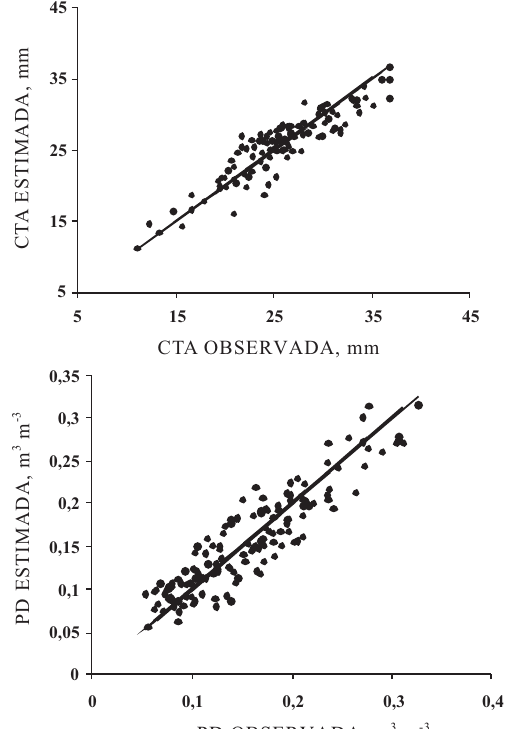
Figura 2. Dispersão dos valores estimados pelos modelos para CTA e PD em torno da reta 1:1.